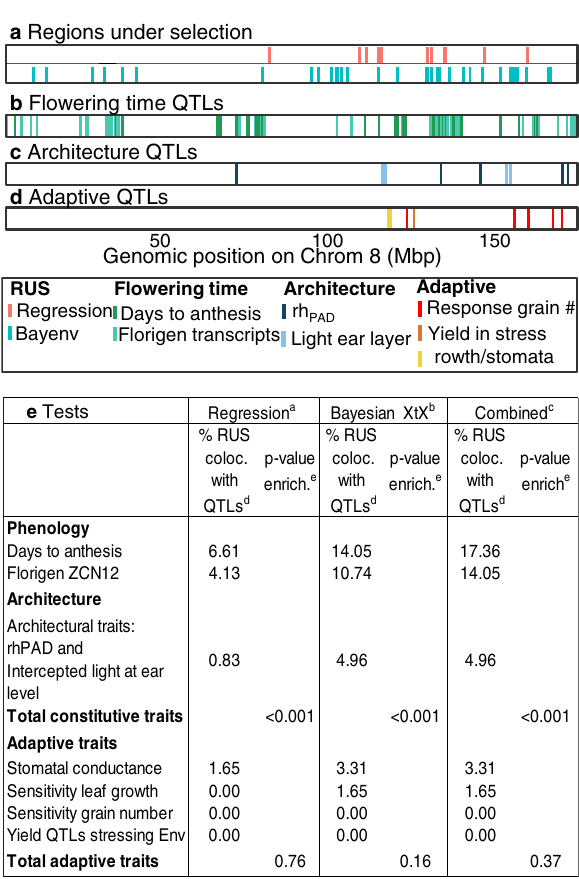
Fig. 9 Why adaptive traits were not selected by yield-based breeding? Instable effects on yield may have caused non-selection of corresponding alleles. Effects of the six QTL are presented in a , averaged per environmental scenarios as in Millet et al. 2016. The proportions of positive alleles at adaptive (orange) vs constitutive (green) QTLs are presented in b for the 22 oldest hybrids vs the 22 most recent hybrids of the genetic progress panel. d Allelic effects on yield, predicted in the multi-site experiments ordered by increasing yield ( c ). QTLs with stable effects (green, constitutive traits) vs QTLs with context-dependent effects (orange, adaptive traits). Adaptive QTLs: a1, QTL on Chrom 2, 44.5 Mb affecting ABA synthesis and including an NCED gene; a2, QTL on Chrom 5, 5.4 Mb, colocalizing with maximum stomatal conductance; a3, QTL on Chrom 10, 132 Mb, whose effect increases with temperature; Constitutive QTLs: c1, QTL on Chrom 6, 84.4 Mb, colocalizing with a QTL of rh PAD ; c2, QTL on Chrom 8, 159 Mb, colocalizing with QTLs of fl owering time in fi eld and controlled conditions, and with an eQTL of fl origens ZCN8 and ZCN12; c3, QTL on Chrom 1, 2.4 Mb. Source data in Supplementary Data